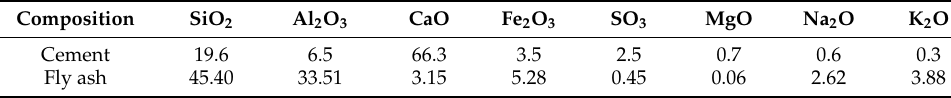
Table 1. Chemistry composition of binder (%) [35,36].